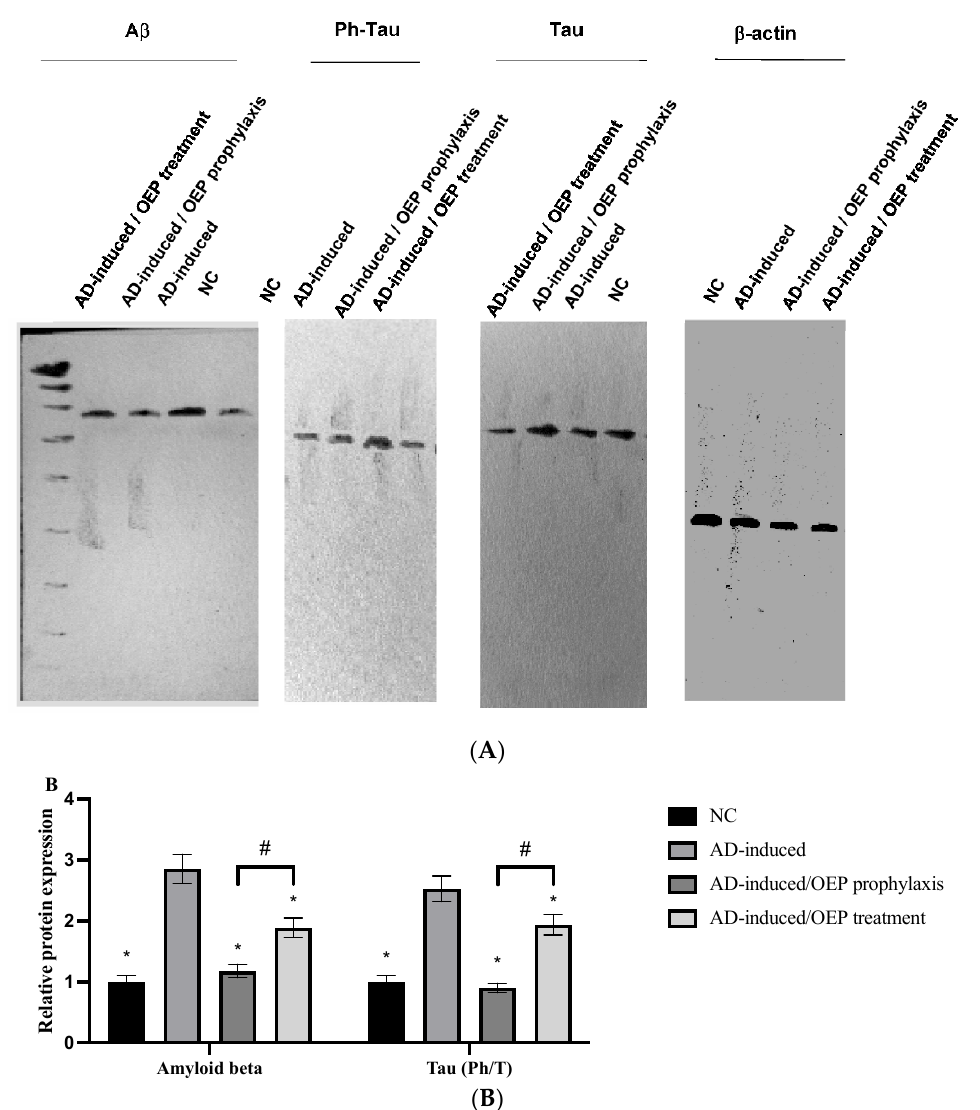
Figure 12. Expression of Ab, phosphorylated tau, and total tau. ( A ) Representative Western blots of Ab, phosphorylated tau, and total tau in different groups. ( B ) Relative protein expression of Ab and Ph/T tau ratios in prophylactic and treated groups of OEP extract. Data represent the mean ±SD ( n = 8). Significant difference was analyzed by one-way ANOVA, followed by a post hoc Dunnett’s test, where * p < 0.001, compared with the AD-induced group, and # p < 0.001, when compared with the AD-induced/OEP treated group. NC: negative control group; AD: Alzheimer’s disease (AD)–induced rats received AlCl 3 orally at a dose of 17 mg/kg body weight daily for 21 days; OEP: Olea europaea L. cv. Picual